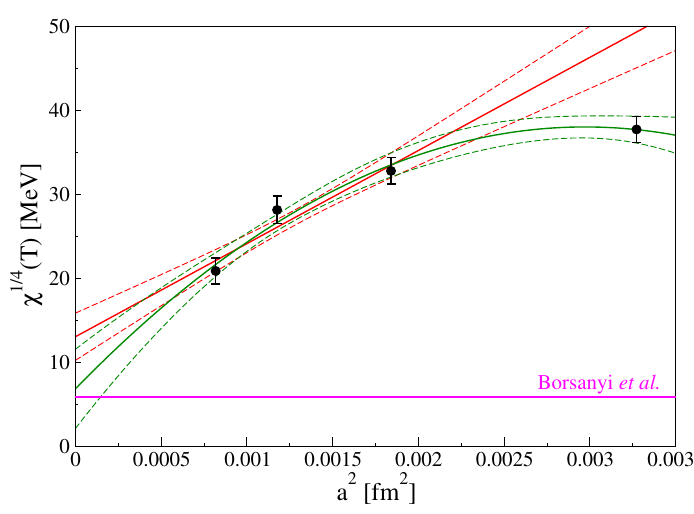
Figure 12 . Fourth root of the topological susceptibility, as a function of a 2 , for T ’ 570 MeV. To two bands represent the result of two di(cid:11)erent continuum extrapolations, taking into account re- spectively O ( a 2 ) or O ( a 4 ) corrections. The horizontal lines is the continuum extrapolation reported in ref. [37] at the same